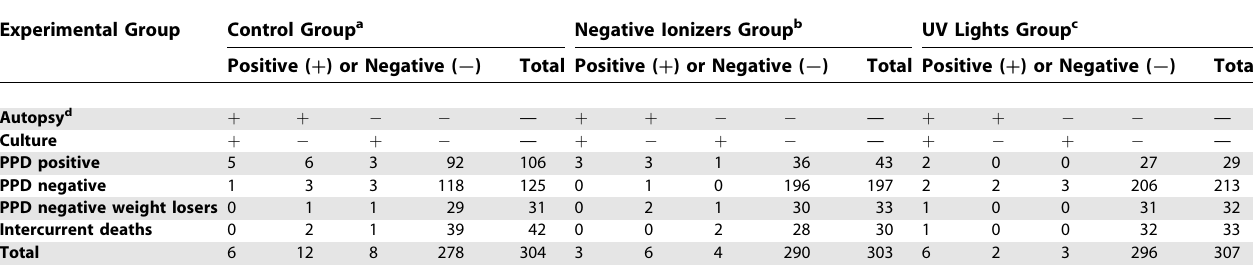
Table 1. PPD Skin Test, Autopsy, and Culture Results for Ward-Air Exposed Guinea Pigs Experimental Group